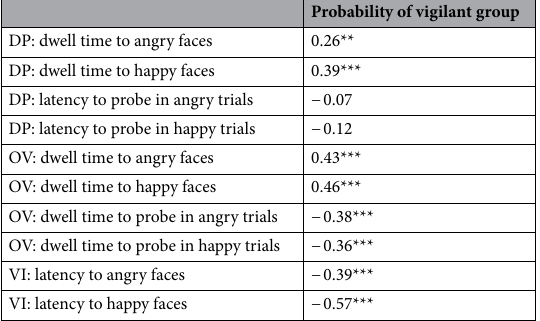
Table 3. Correlations between LPA variables and probability of vigilant group membership. ** p < .01, *** p < .001. DP dot-probe task, OV overlap task, VI vigilance